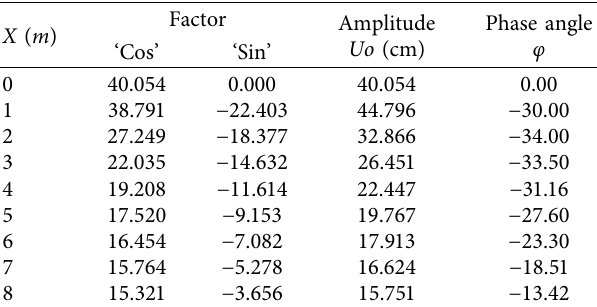
Table 3: Data corresponding to the decoded wave spectrum. X ( m )